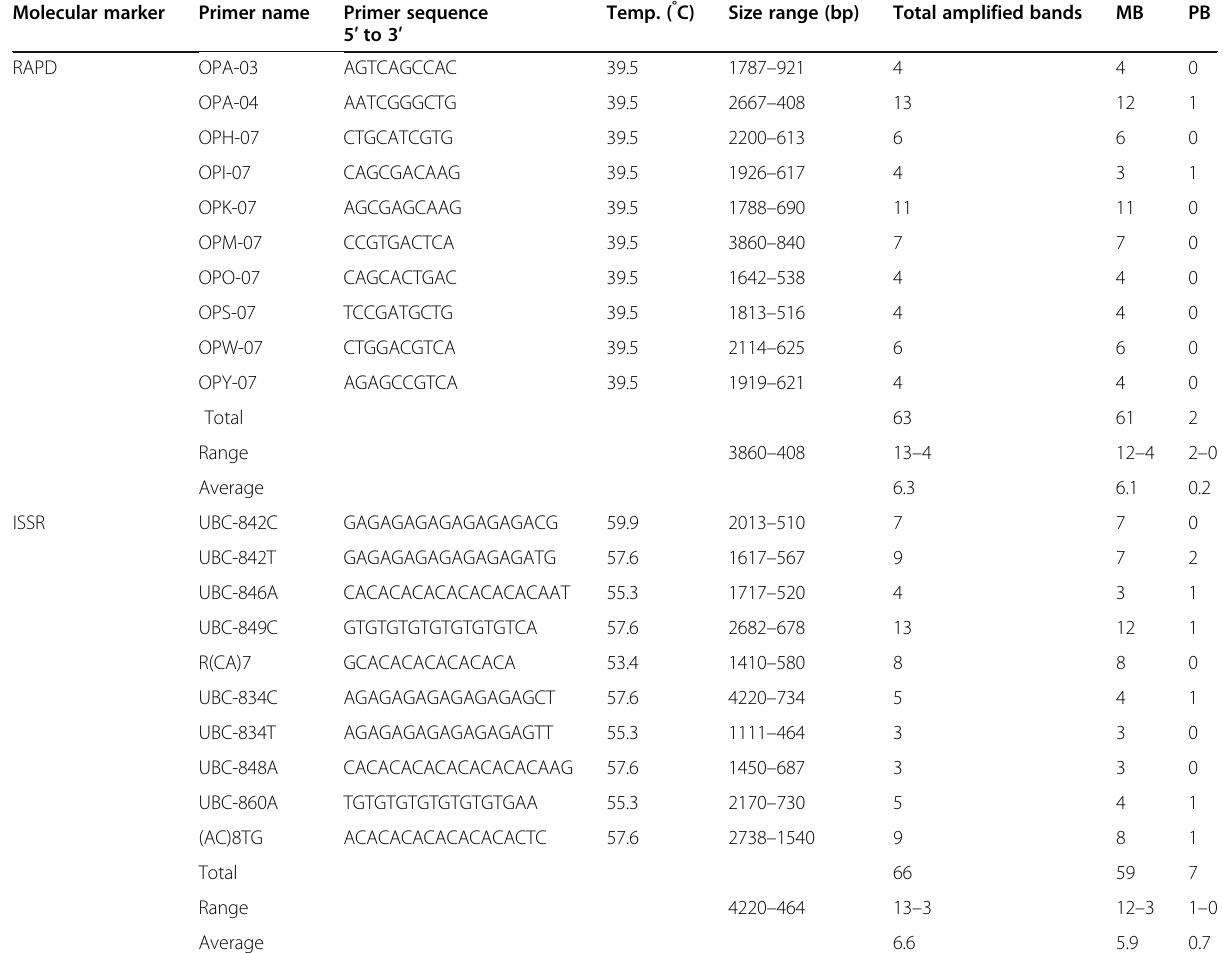
Table 3 List of RAPD and ISSR primers ’ names, sequences, annealing temperatures, bands sizes range, and number of bands amplified including monomorphic (MB) and polymorphic bands (PB) Molecular